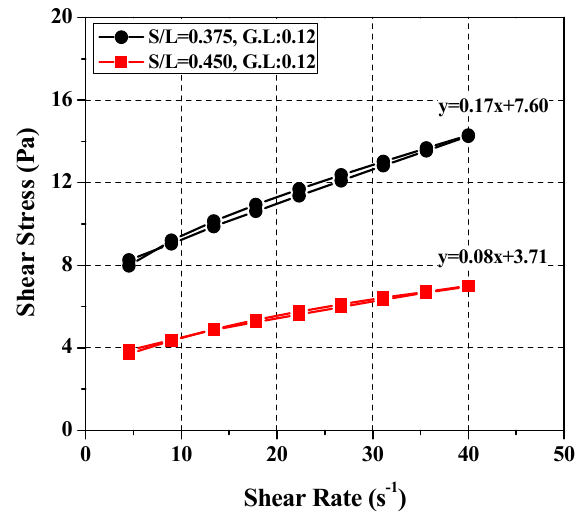
Figure 11. Test results of rheology for SRM. Table 7. Mixing ratios of cement paste and SRM for verification.